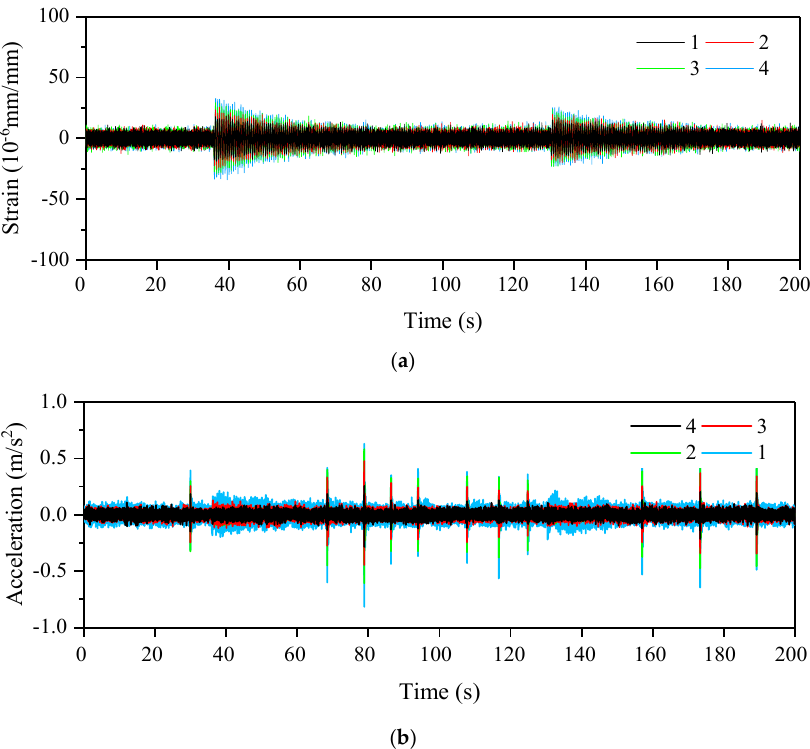
Figure 4. Structural response of the wind turbine model. ( a ) Strain responses; ( b ) acceleration signals.